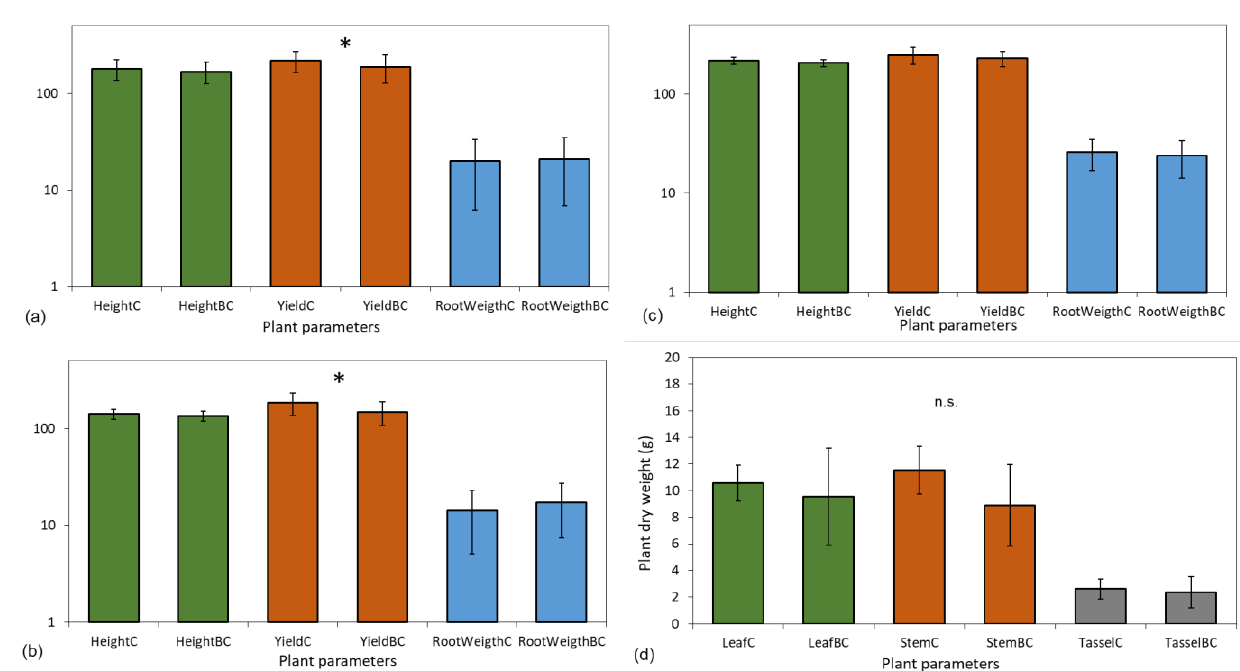
Figure 2. Maize growth of height (cm), crop yield (g), and root dry weight (g) for ( a ) the two-year averages, ( b ) 2017, ( c ) 2018 and ( d ) aboveground biomass in control (C) and biochar (BC) amended soils. * indicates statistically significant differences between treatments. n.s. represents no significant differences.